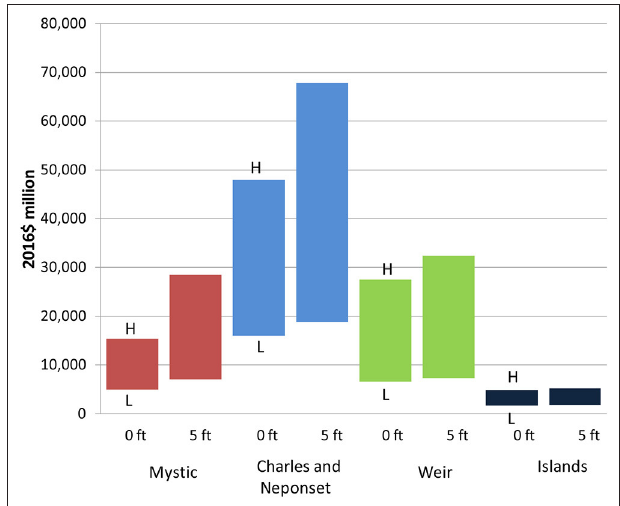
FIGURE 8 | Effects of sea level rise (SLR) on ecosystem asset values (2016$ million, sliding scale